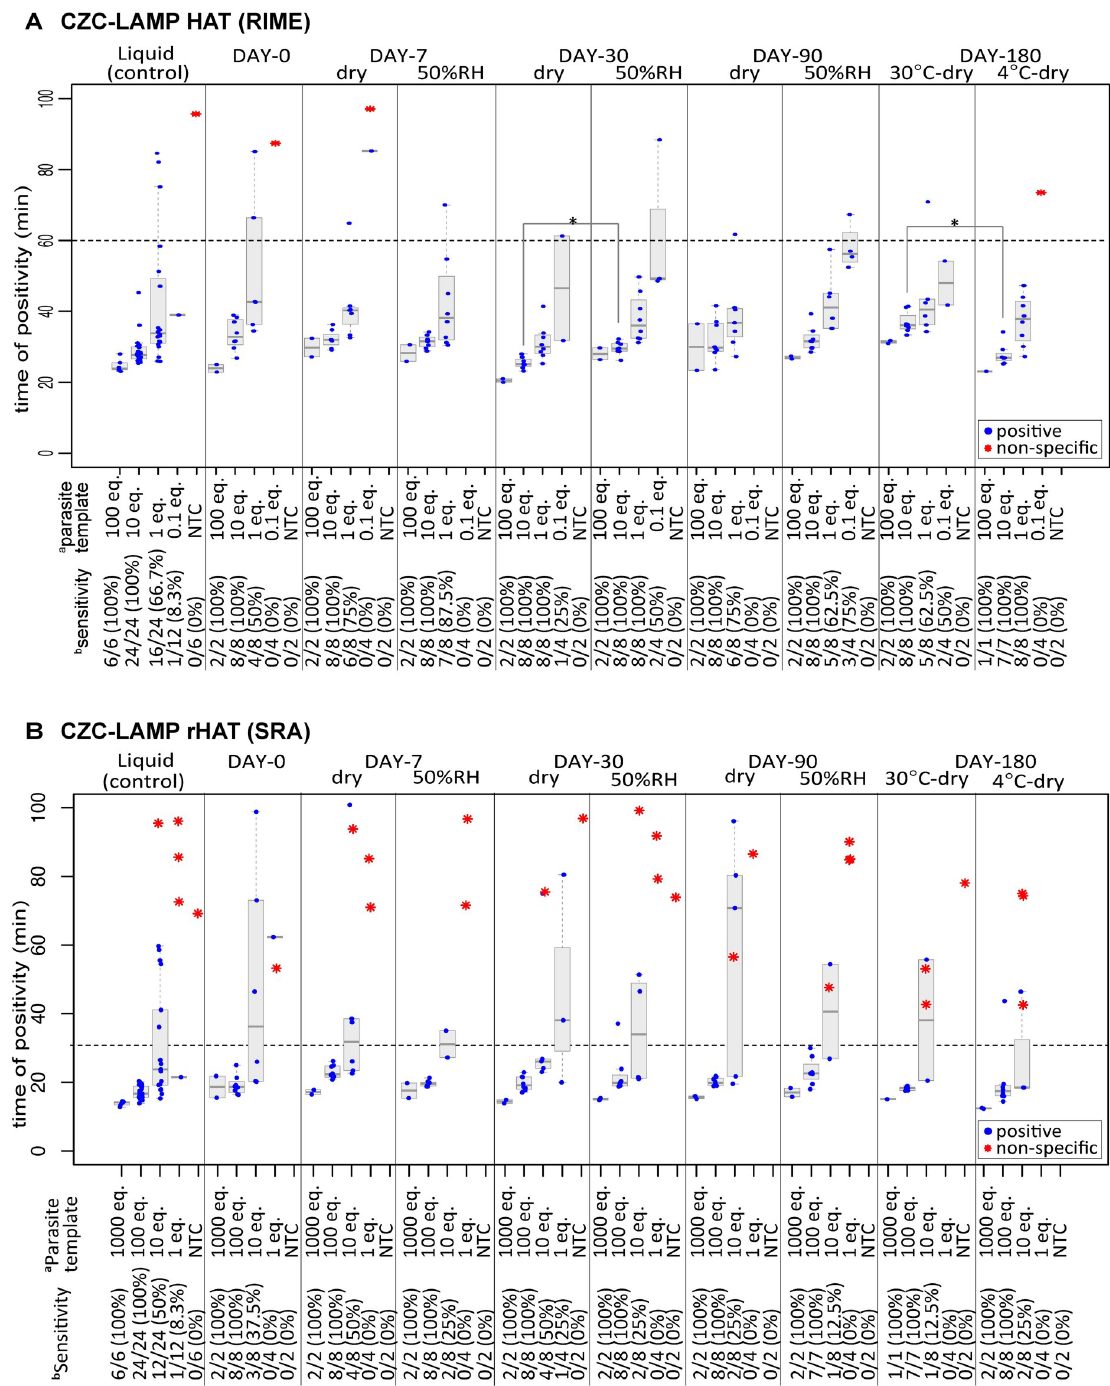
Fig 3. Analytical sensitivities of CZC-LAMPs after storage. (A) CZC-LAMP HAT (RIME primer set) and (B) CZC-LAMP rHAT (SRA primer set) test tubes were stored in dried or 50% relative humidity (RH) environments at 30 ˚C for 0–90 days, or at 4 ˚C or 30 ˚C under dry condition for 180 days. The time of positivity and specificity according to melting temperature (Tm value) were analyzed using real- time PCR machine. The genuine positive reaction time points according to the Tm values are shown as blue plots, while non-specific amplifications are plotted as red asterisk. The dashed line presents the threshold of the reaction time to calculate sensitivity. Conventional liquid LAMP (liquid) was used as the reaction control. a Indicated equivalent numbers of Trypanosoma brucei rhodesiense lysate per reaction (eq.) were used as templates. b The positivity was judged at the 60-min (A; CZC-LAMP HAT) or 30-min (B; CZC-LAMP rHAT) incubation time threshold. Statistical significance was assessed using Mann-Whitney U test ( � p < 0.001).